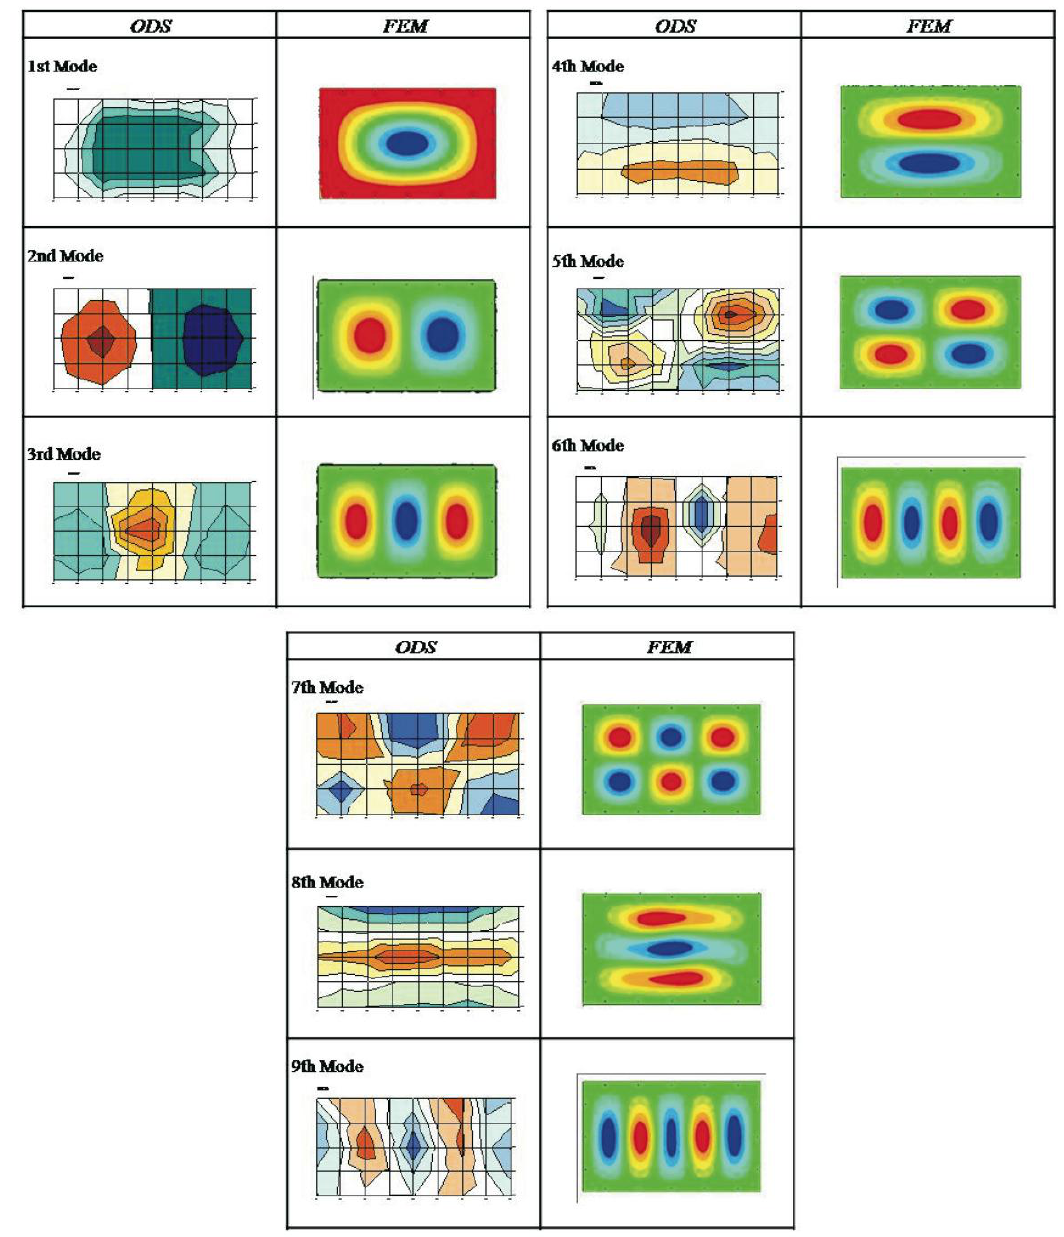
Figure 5. Naked Metal Sheet: ODS and Mode Shape